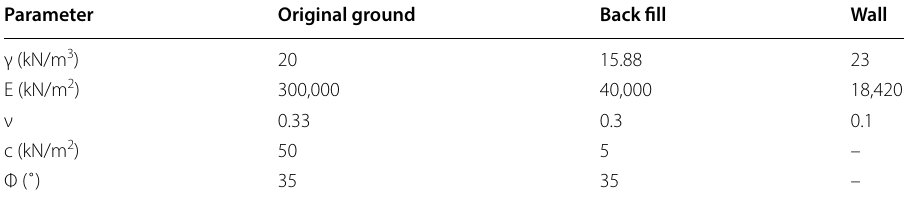
γ, unit weight of soil; E: Young’s modulus; ν, Poisson’s ratio, c, Cohesion; Φ’, angle of shearing resistance